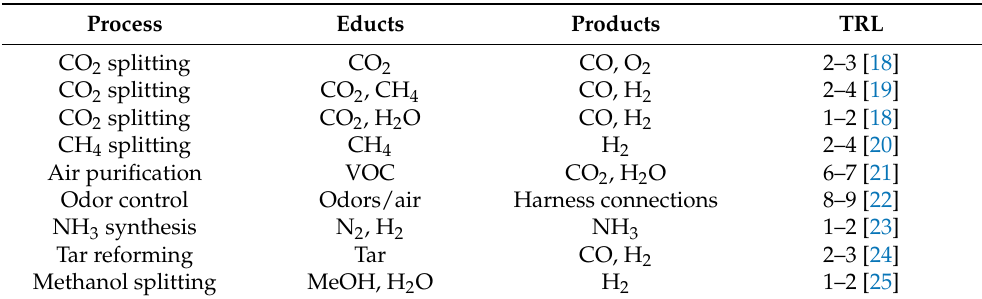
Table 1. Applications of plasma catalysis and their technology readiness levels (TRL) in accordance with [15]. (VOC = volatile organic